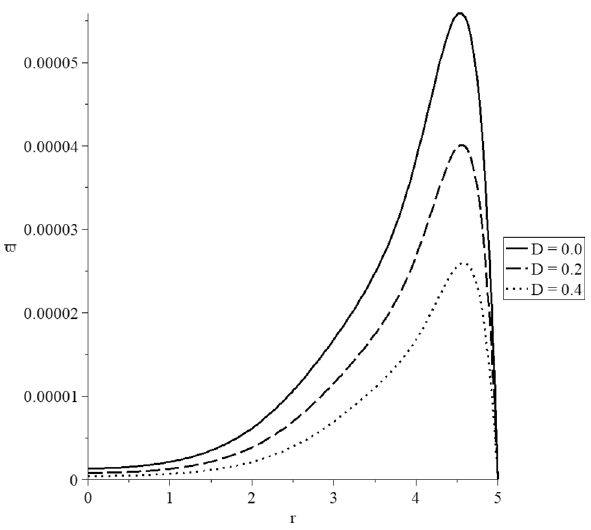
Figure 14. The stress-strain energy distribution with various values of the mechanical damage